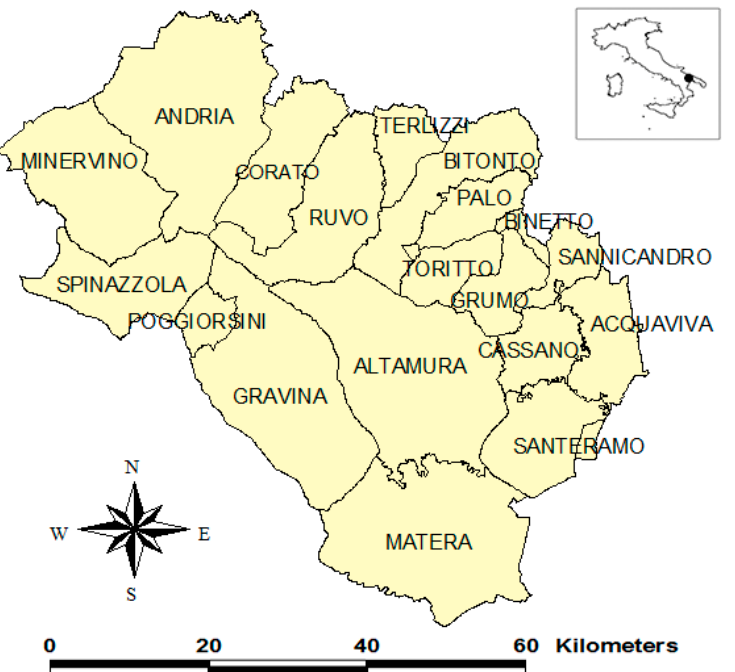
Figure 1. Alta Murgia (Apulia and Basilicata regions, Southern Italy). The municipalities involved in this study are shown.